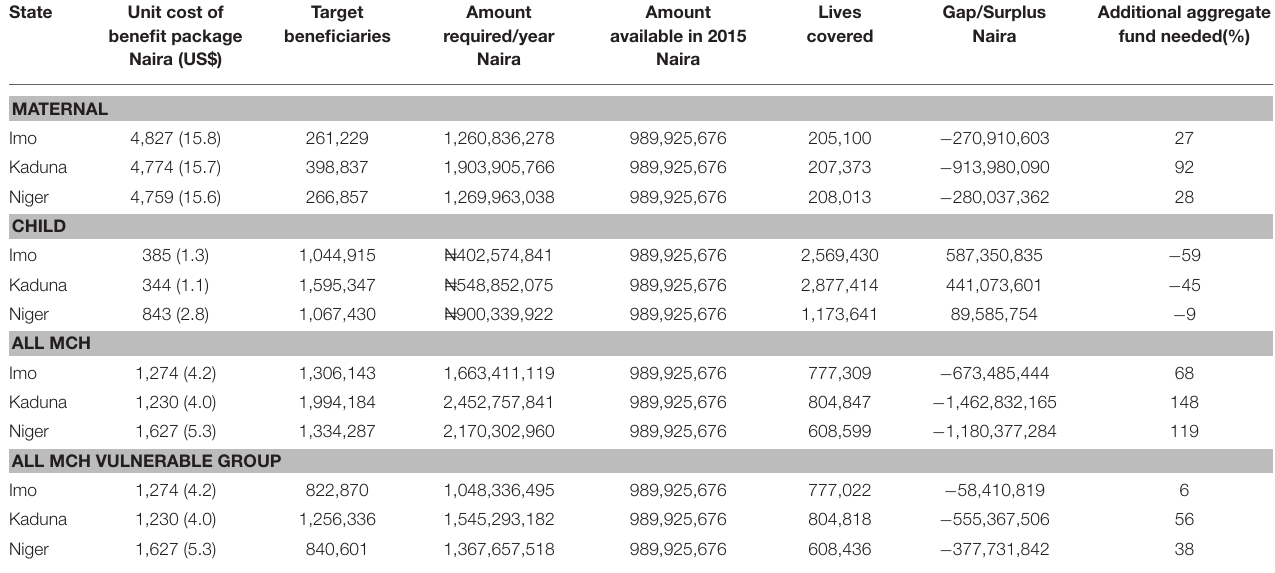
TABLE 7 | Scenario: 1c (Revenue: 95% of BHCPF).